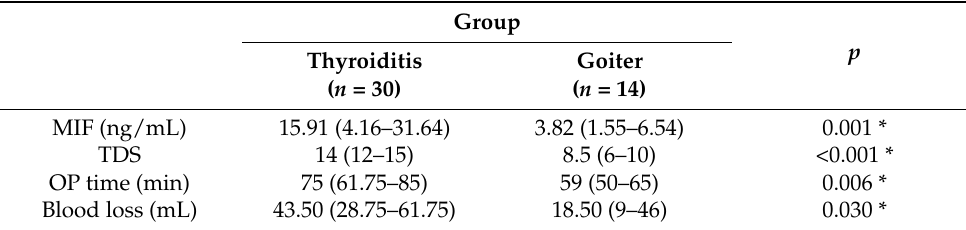
Table 2. Correlation of MIF, TDS, OP time, and blood loss in different groups.